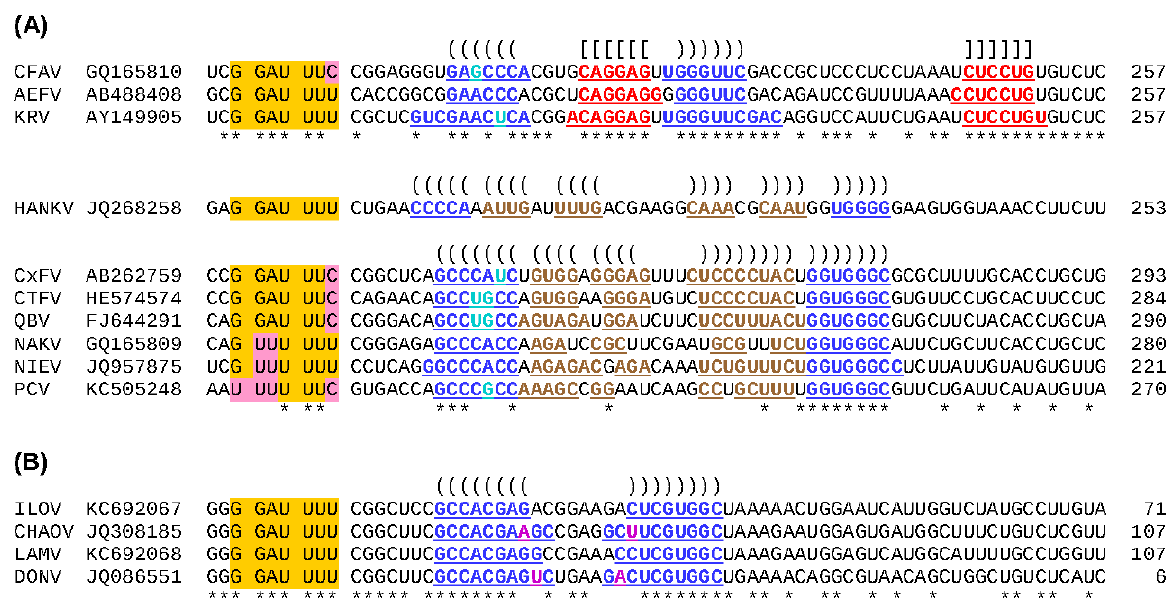
Figure 3. Predicted -1 frameshift sites in ISFs. ( A ) Apparently all cISFs contain a -1 PRF site just downstream of the predicted junction between the regions encoding NS1 and NS2A. Frameshifting results in translation of a long overlapping ORF, termed fifo . The ‘slippery’ heptanucleotide sequence at which the -1 nt shift occurs is highlighted in orange, with nucleotide variations highlighted in pink. Ribosomes that shift -1 nt read the last nucleotide of the heptanucleotide twice. Predicted frameshift stimulatory elements (an RNA pseudoknot structure in the CFAV clade and an RNA stem-loop structure in the HANKV and CxFV clades) are annotated: nucleotides predicted to be involved in base-pairing interactions are colored and underlined, and predicted base-pairings are indicated with “()”s and “[]”s (see also Figure 4). Conserved positions are indicated with “*”s. The length (in codons) of the fifo ORF in each sequence is indicated at right; ( B ) There is strong comparative genomic evidence that members of the dISF clade encompassing ILOV, CHAOV, LAMV and DONV contain a functionally utilized -1 PRF site towards the 3' end of the region encoding